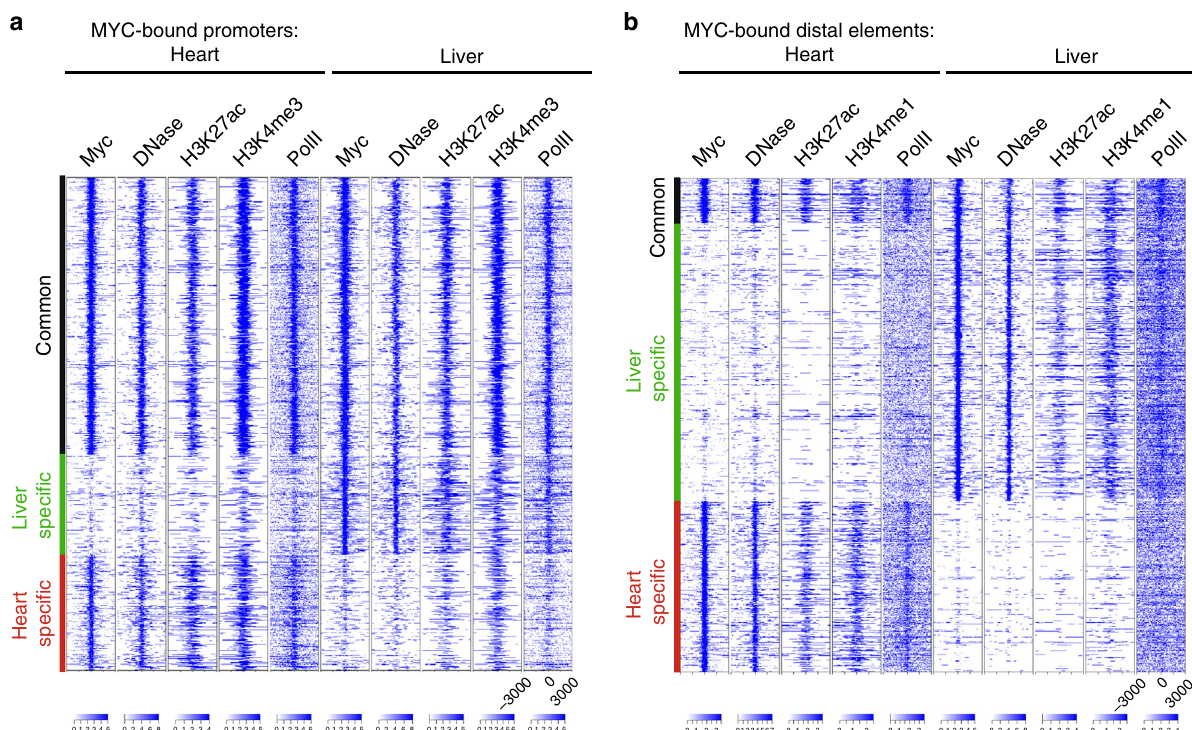
Fig. 3 Myc binding is dictated by chromatin access. a Heatmap of peaks called by DNAse treated, acetylated H3K27 (H3K27ac), tri-methylated H3K4 (H3K4me3) and RNA polymerase II (PolII) ChIP sequencing at Myc-bound promoter elements that are common between both the liver and heart (common-black), or speci fi c for an individual tissue (liver speci fi c — green, heart speci fi c — red). Myc ChIP sequencing was performed on the heart and livers isolated from R26 CMER/ + mice 4 h post administration of 4-OHT, overlap of n = 2. PolII ChIP sequencing performed on the heart and livers isolated from wild-type ( R26 + / + ) mice, overlap of n = 2. ChIP sequencing data for DNase treated, H3K27ac and H3K4me3 were taken from the ENCODE